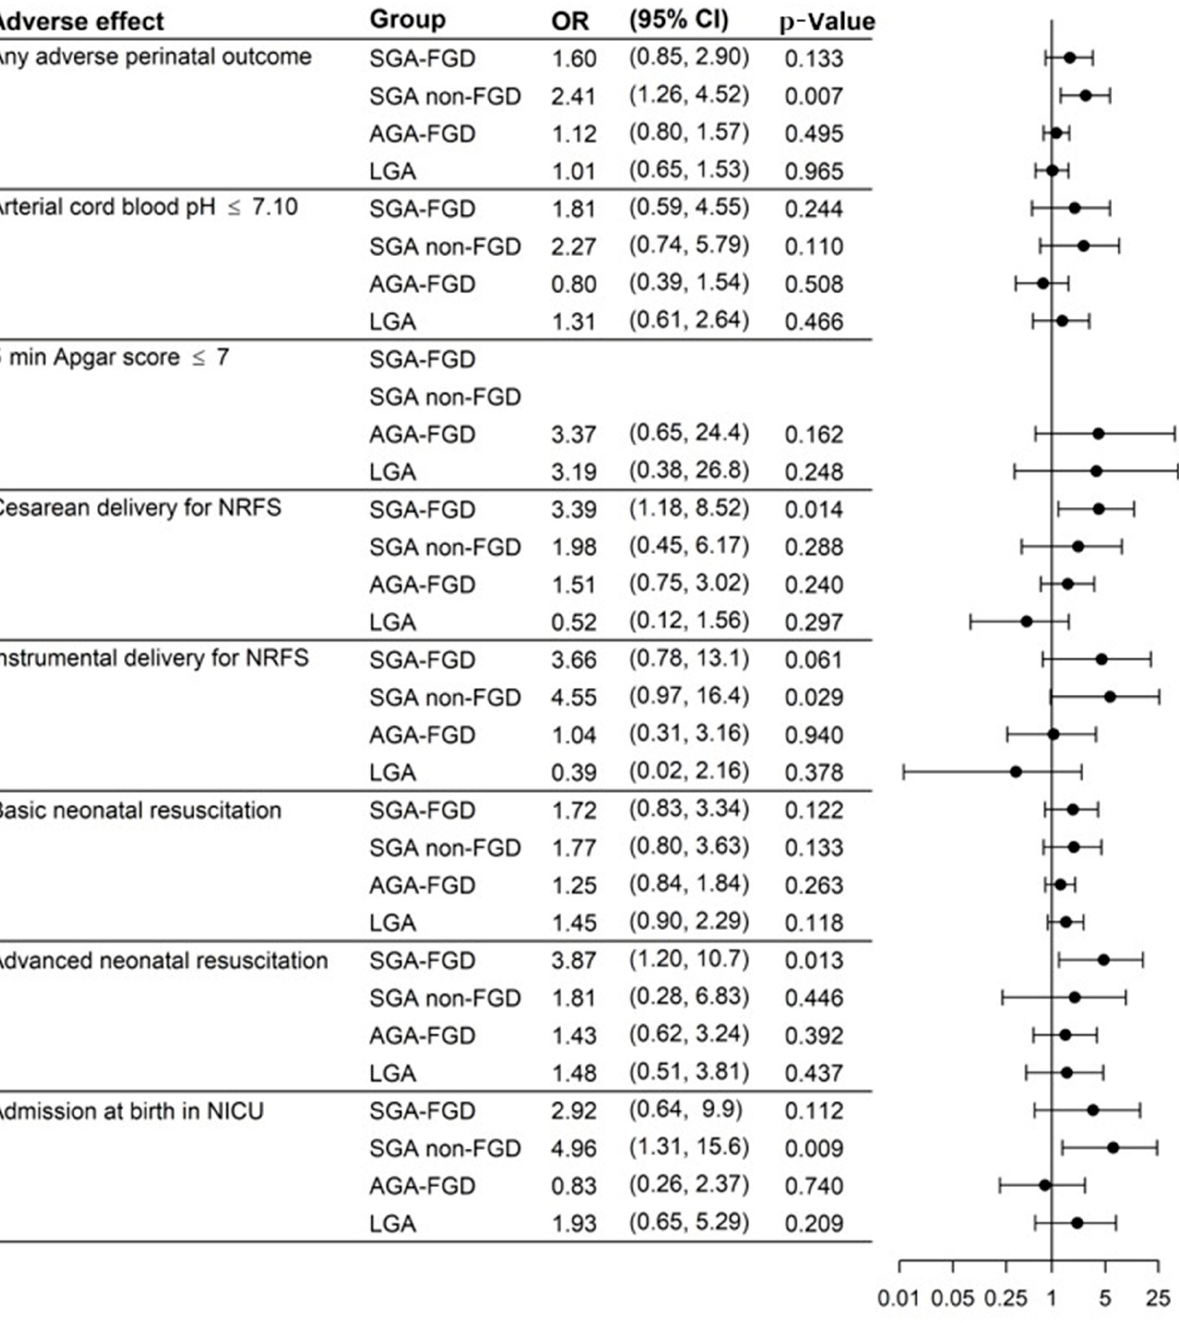
Figure 3. Results of the logistic regression model (univariate analysis). AGA FGD: appropriate for gestational age with fetal growth detention; AGA non-FGD: appropriate for gestational age without fetal growth detention; LGA: large for gestational age; NICU: neonatal intensive care unit; NRFS: non-reassuring fetal status; SGA FGD: small for gestational age with fetal growth detention; SGA non-FGD: small for gestational age without fetal growth detention.